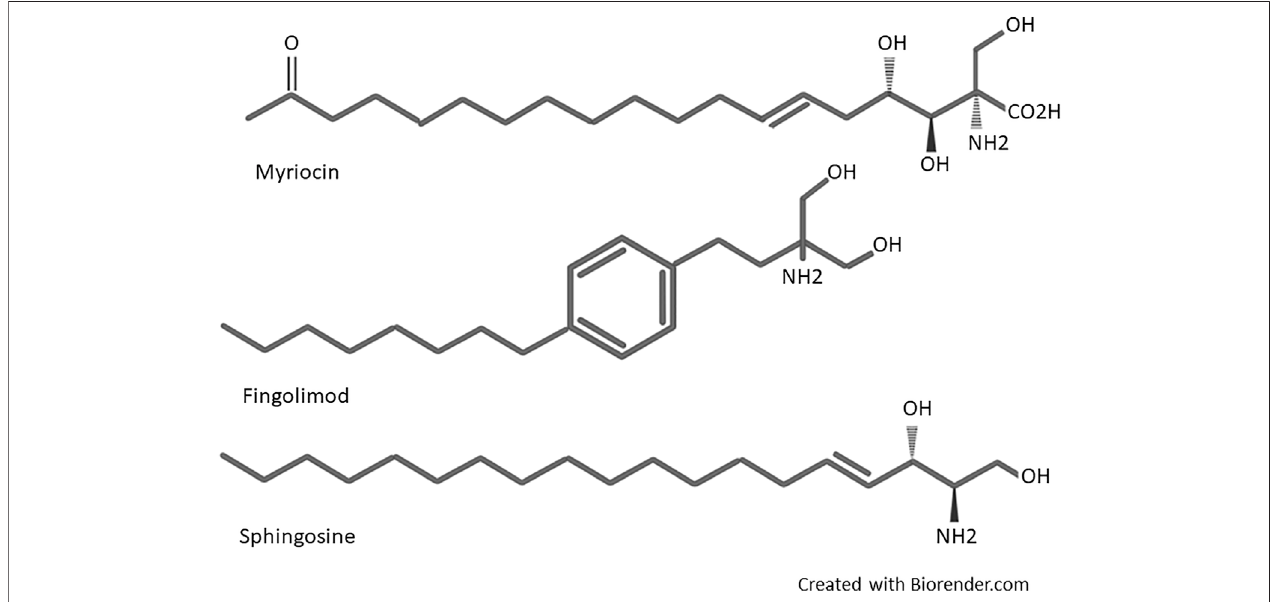
FIGURE 1 | Structure of myriocin, fi ngolimod, and